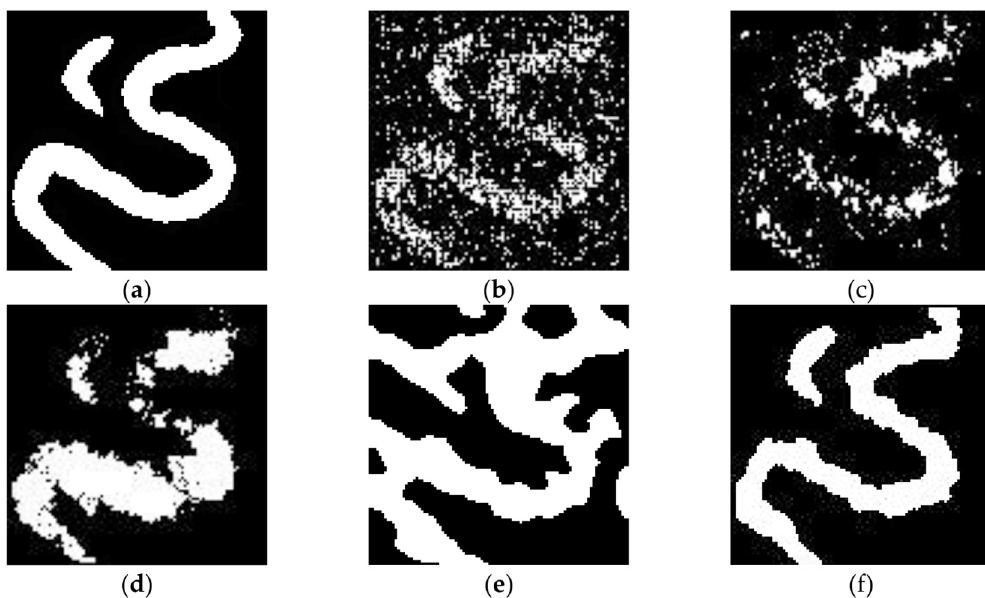
Fig 9. Random simulations of the channel model: (a) target model; (b) realization using the conventional MPG method based on a DFNN; (c) realization using the repeated simulation method; (d) realization with the optimized training data organization; (e) realization using SNESIM; (f) realization using the optimized MPG method based on a DFNN.